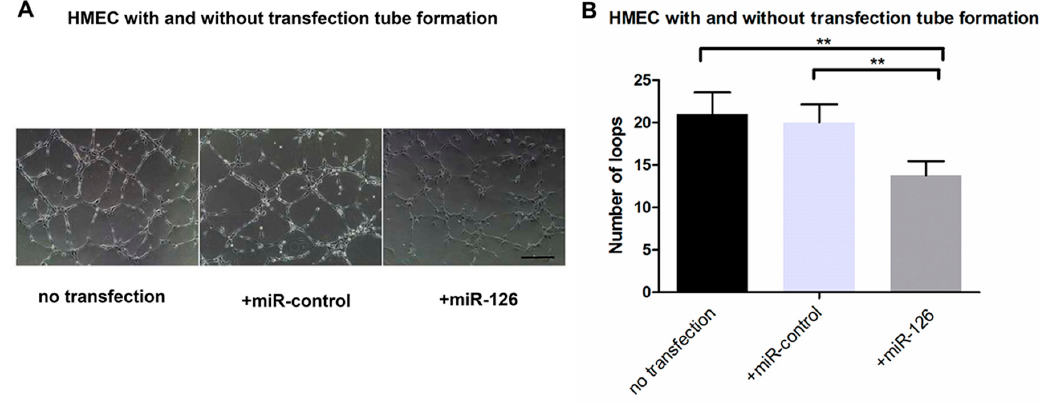
Figure 6. HMECs tube formation after transfection: ( A ) representative images of HMEC tube formation, without transfection and after transfected with miR-control or miR-126 mimic ; Scale bar = 20 µ m and ( B ) analysis of capillary-like tube formation of HMECs in different groups with no transfection, transfected miR-control or miR-126 mimic . Data are present as mean number of loops formed ± SD ( n = 4), ** p < 0.01.